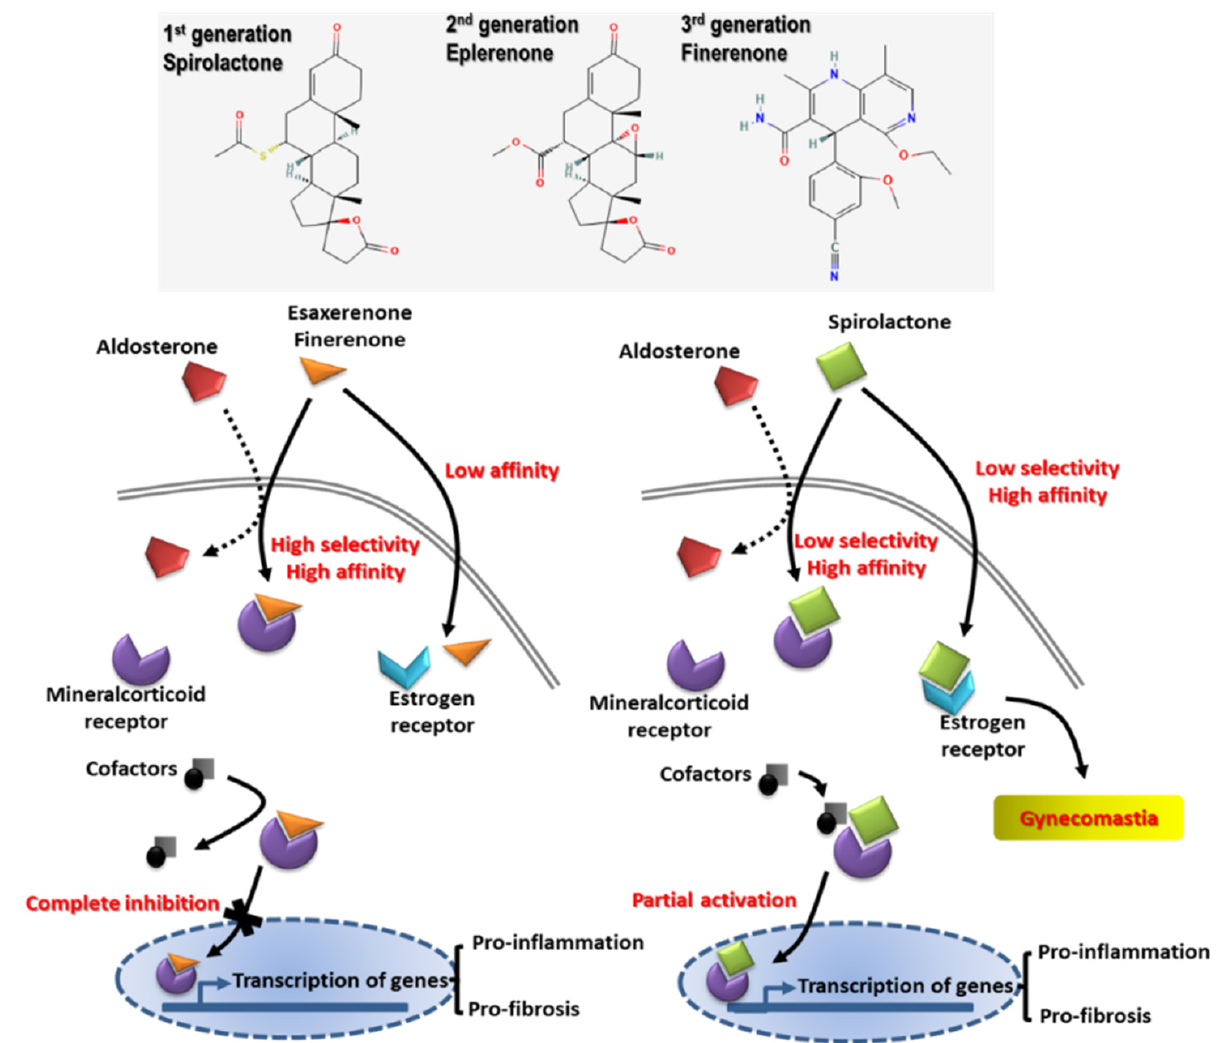
Figure 4. The structure and action mechanisms of different MRAs generations such as spironolactone, eplerenone, and novel nonsteroidal MRAs (esaxerenone and finerenone). Novel nonsteroidal MRAs exert better anti-fibrotic and anti-inflammatory effects with renal tubular sparing effects on hyperkalemia.